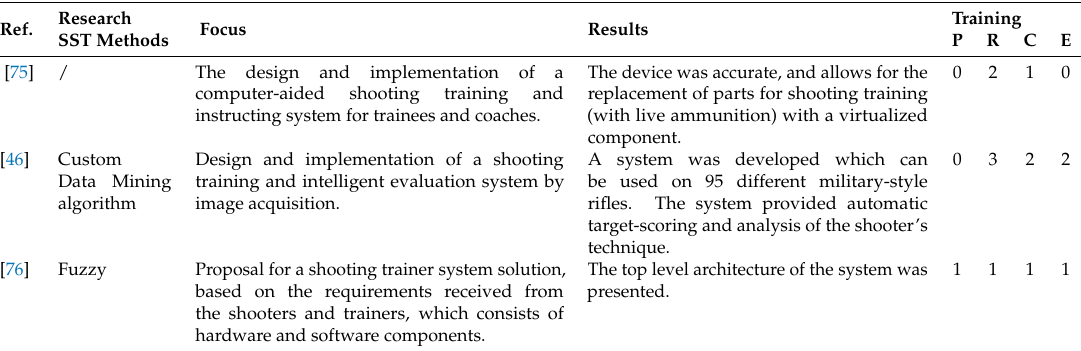
Table 10. Identified studies in the domain of shooting.